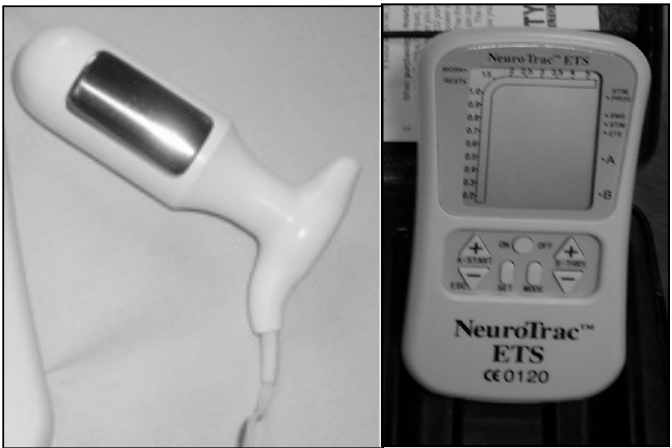
Figure 1. The veriprobe vaginal electrode and the NeuroTrac ETS stimulation device (source: author’s photograph).